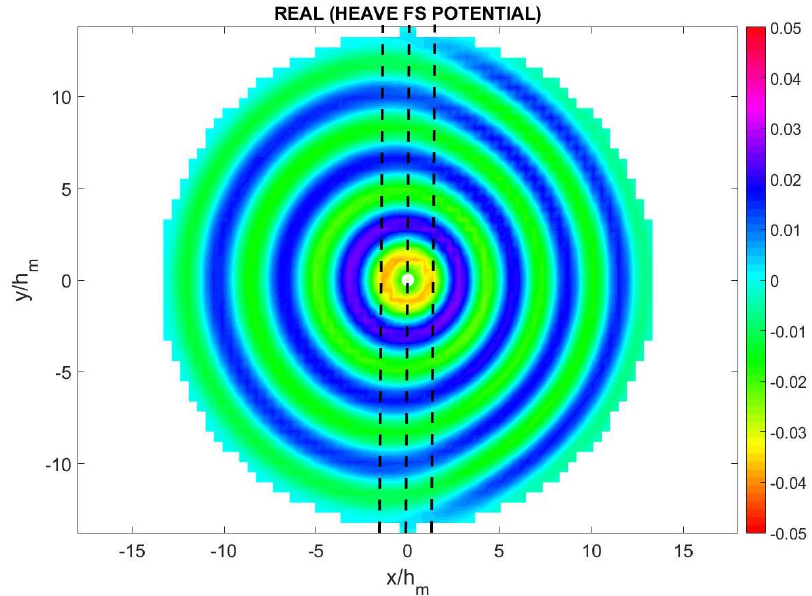
Figure 6. Heave radiation field on the free surface for WEC frequency ω / 0.7 a g over the variable bottom topography ( h 1 = 1.5 m, h 3 = 0.5 m, α bot = 0.5), as calculated by the present method. The bottom contours are indicated by using dashed lines.